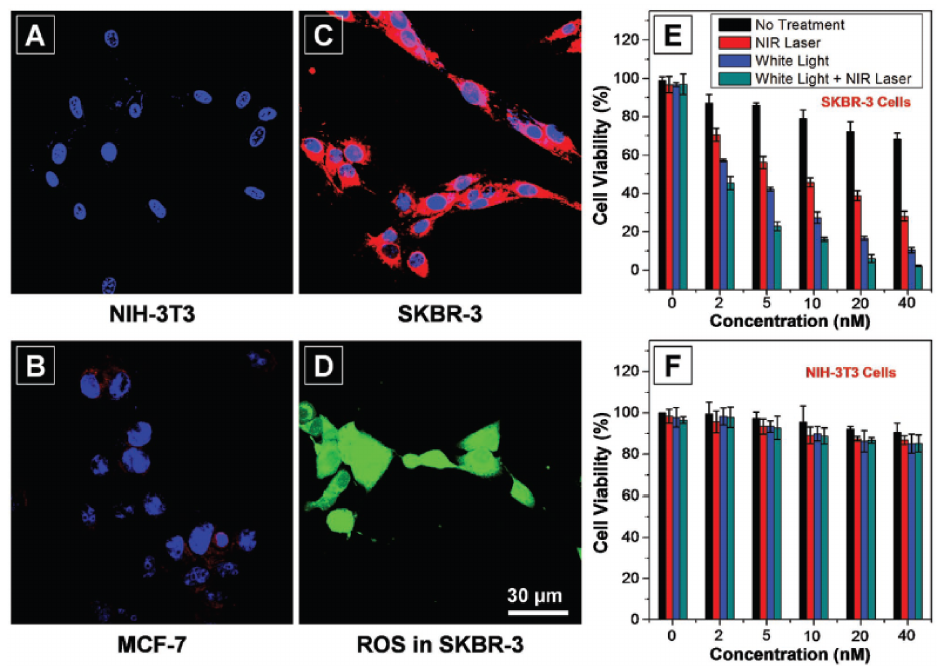
Figure 16. Confocal images of ( A ) NIH-3T3; ( B ) MCF-7; and ( C ) SKBR-3 cells after 4 h incubation with anti-HER2-CPNPs (2 × 10 − 9 M). The red fluorescence of anti-HER2-CPNPs is collected above 505 nm upon excitation at 488 nm. The blue fluorescence of Hoechst from the nucleus is collected from 430 to 470 nm upon excitation at 405 nm; ( D ) detection of intracellular ROS generation by DCF-FA in SKBR-3 cells after incubation with anti-HER2-CPNPs (2 × 10 − 9 M, 4 h) followed by light irradiation (30 s). Images ( A – D ) share the same scale bar of 30 µ m. Cell viabilities of ( E ) SKBR-3 and ( F ) NIH-3T3 cells after incubation with anti-HER2-CPNPs (2 × 10 − 9 M, 4 h) followed by photodynamic and photothermal treatment. Reproduced with permission [68]. Copyright: 2017,